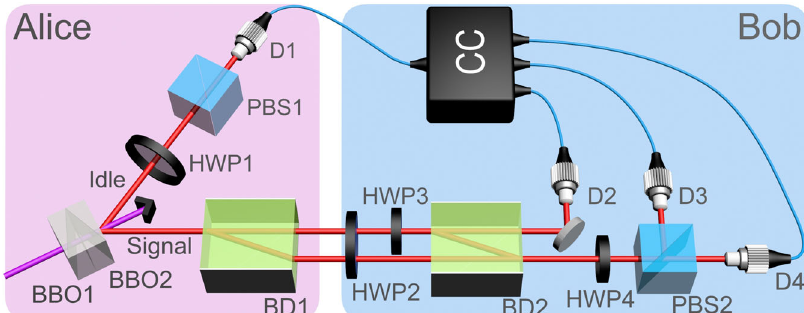
ffiffiffiffiffiffiffiffiffiffiffi p ffiffiffi p 1 (cid:1) a H j i (cid:1) a V j i , thus the signal